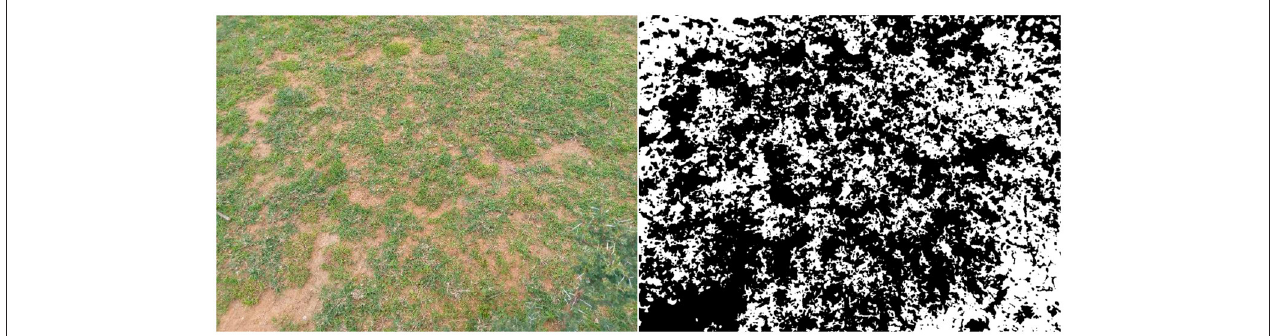
FIGURE 9 | Digital image collected via mobile phone using the KAZNET platform. On the right, the classified image used to calculate the green grass cover.